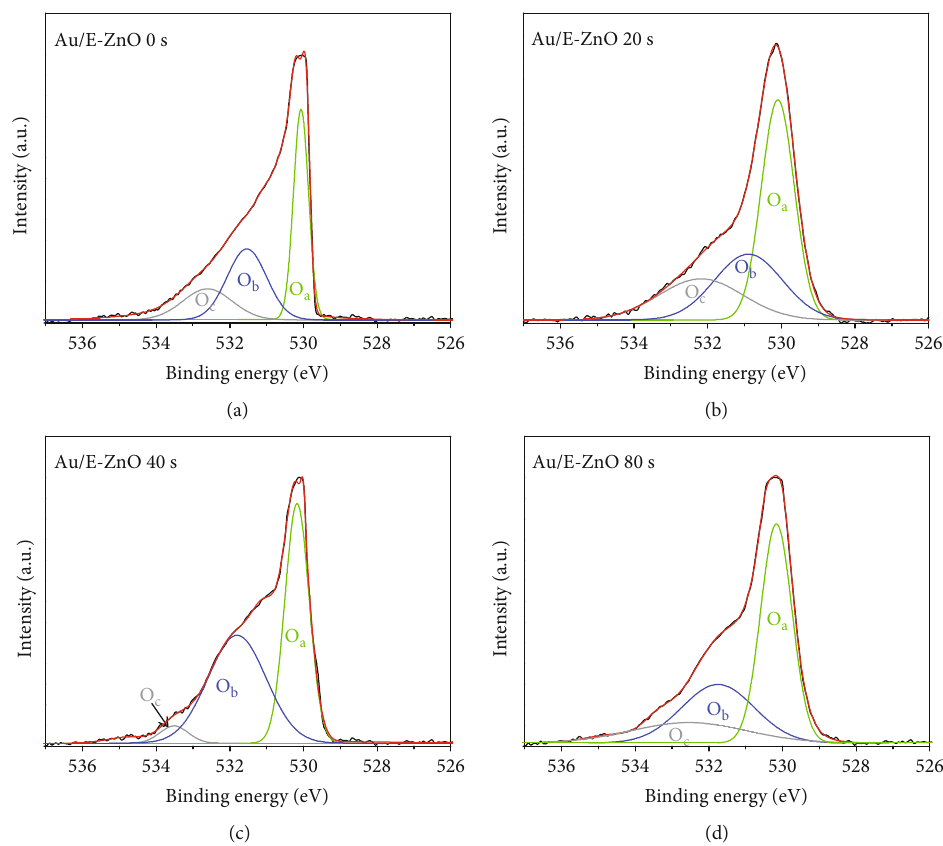
Figure 8: (a – d) O 1s core level fi tting of XPS spectra for Au/E-ZnO Schottky heterojunction nanocomposites with di ff erent loading times (0 s, 20 s, 40 s, and 80s), respectively.